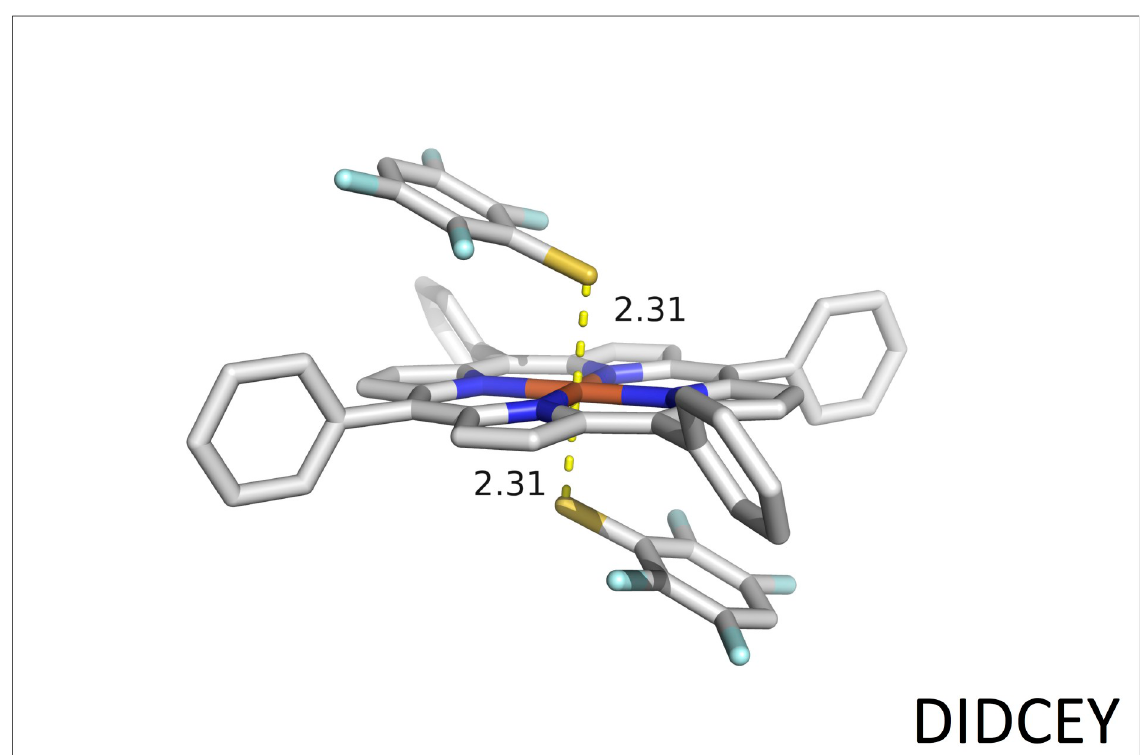
Fig 4. DIDCEY crystal structure. 3D representation of the DIDCEY structure containing a porphyrin ring with two 2,3,5,6- tetrafluorobenzenethiolate ions coordinated to the Fe atom [43].